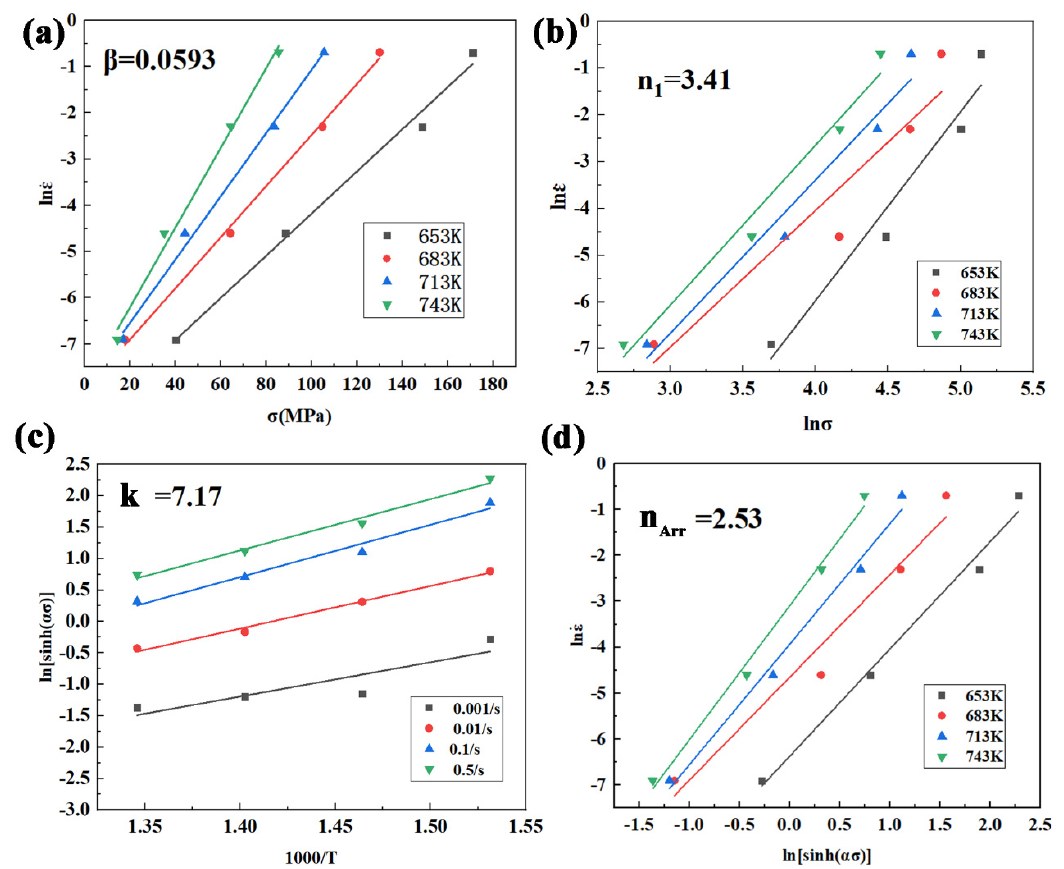
. . . ε − ln σ ; ( b ) ln ε − ln σ ; ( c ) ln ε − ln [ sinh ( βσ )] ;